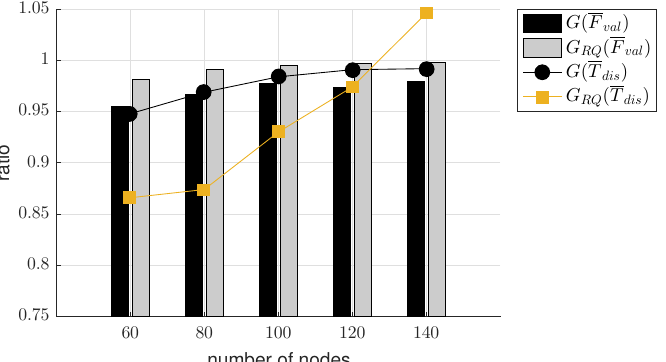
Figure 14. The effect of the duplication ratio approximation on the number of valid frames ( F val ) and traffic dissemination time ( T dis